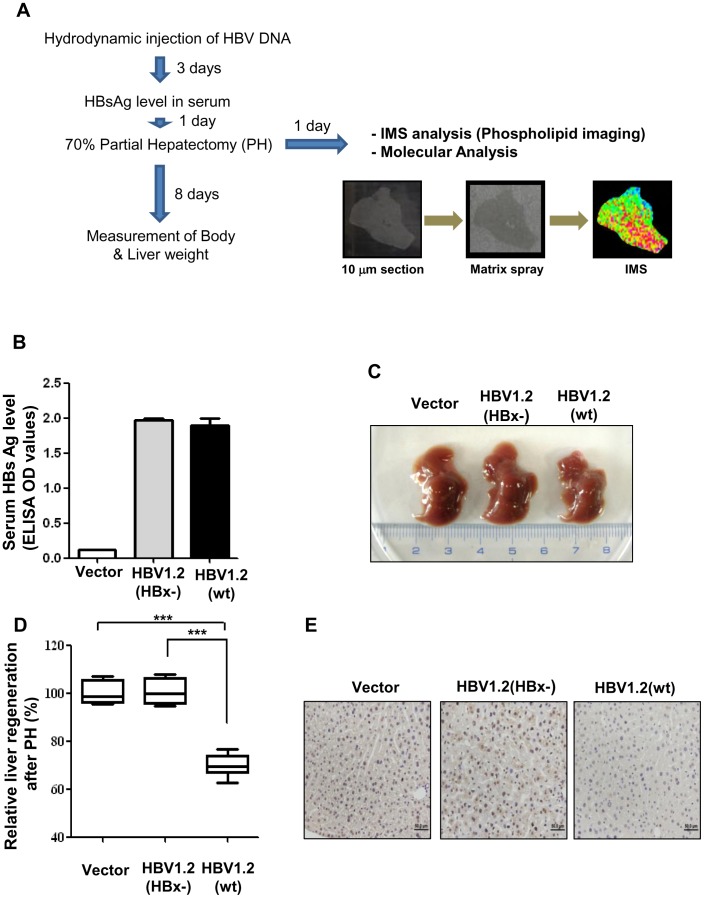
Characterization of HBV mouse model and virus-mediated inhibition of liver regeneration.(A) Overall scheme of experimental procedures. B–E. Validation and characterization of the mouse model of HBV infection used in this study. (B) The HBsAg level in mouse serum at 3 days after hydrodynamic injection. (C) Inhibition of liver regeneration by HBx in HBV mouse model. Macroscopic evaluation of regenerated livers of HBV or HBx mouse model at 8 days after partial hepatectomy. (D) Box plots of liver weight/body weight at 8 days after partial hepatectomy. (E) Ki 67 (marker of cell proliferation) expression in formalin-fixed liver tissues obtained at 48 h after partial hepatectomy. Data are depicted as mean ±S.D. and are representative of three independent experiments. ***, P<0.001 compared with mock vector and HBV1.2 (HBx-) (n = 5∼6 mice per each group).